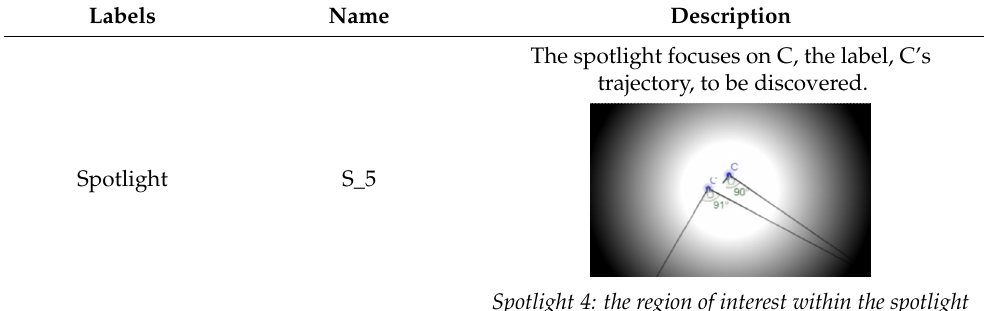
Panel 11: two overlapped instances of the dynamic object during drag- Table 8. Main elements from the analysis of Excerpt 4. Table 8. Main elements from the analysis of Excerpt